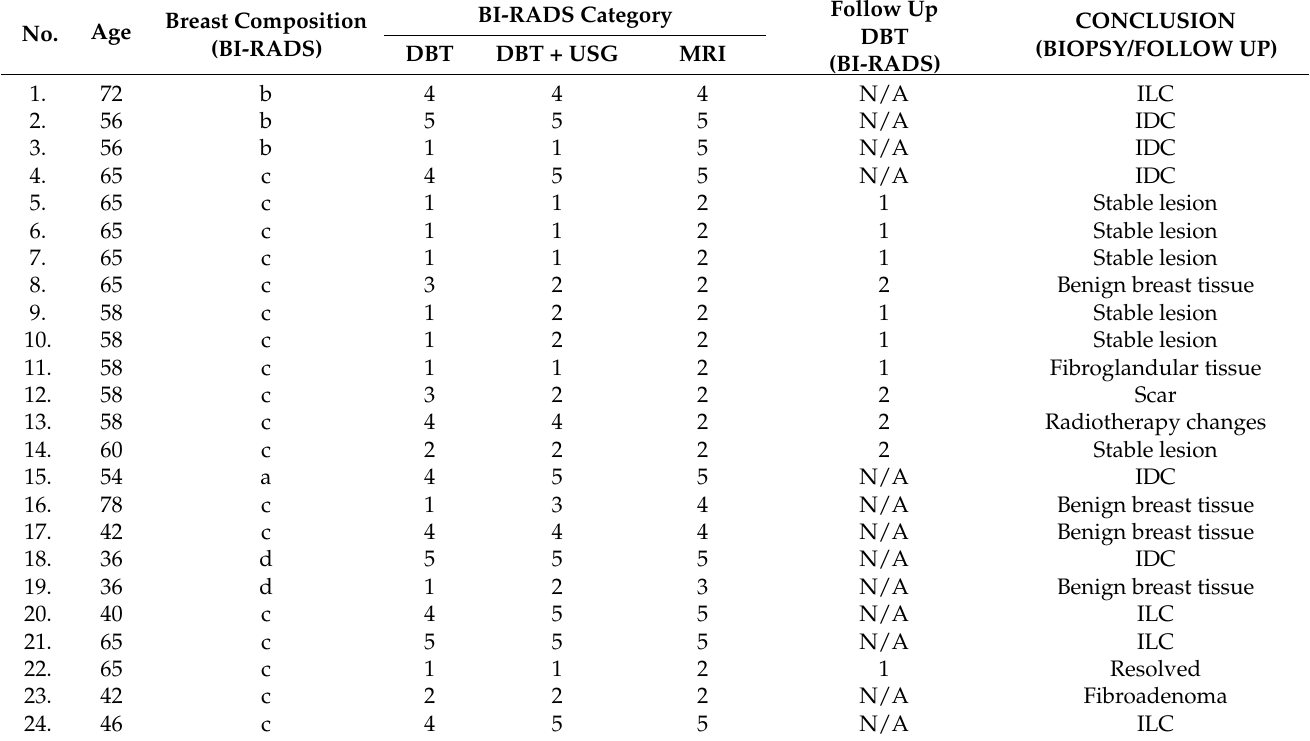
Table 2. Summary of lesions detected in the present study.